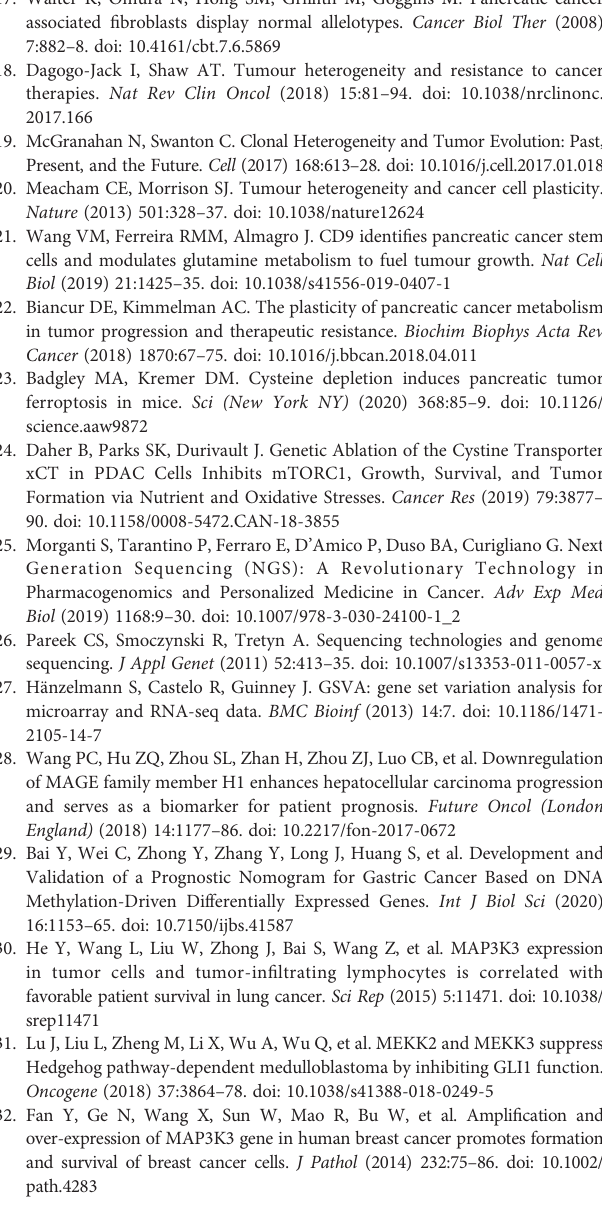
Supplementary Figure 1 | GO analysis of DEGs between PDAC samples with high and low mRNAsi values.